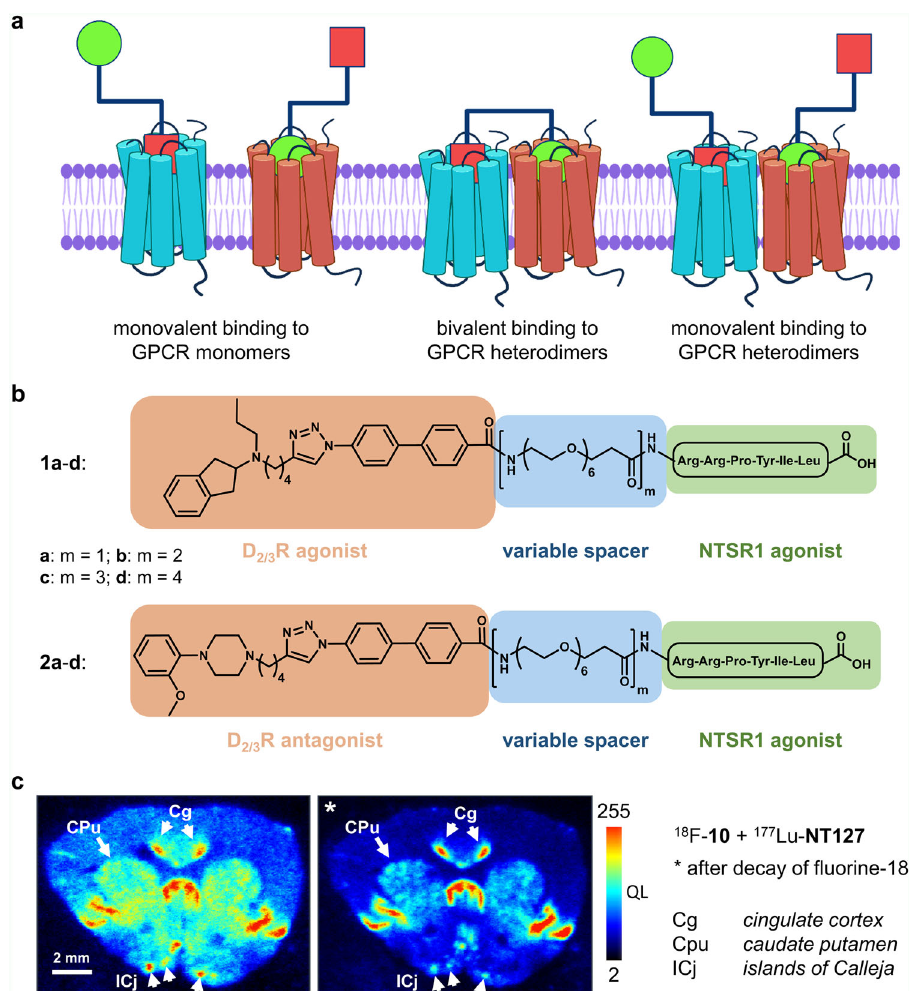
Fig. 1 Bivalent ligands targeting heterodimers and distribution of D 3 R and NTSR1 in the rat CNS. a Schematic representation of binding modes of heterobivalent ligands at dimeric or monomeric GPCRs, created with biorender.com. b Bivalent ligands used in the present study are composed of a dopamine receptor agonist ( 1a - d ) or antagonist ( 2a - d ), a linker of fl exible size ( m = 1-4 PEG-spacer units) and NT(8-13) as peptide NTSR1 agonist. c In vitro rat brain autoradiography with the D 3 R-selective radioligand 18 F- 10 39 and the NTSR1-selective radioligand 177 Lu- NT127 40 visualises the expression of D 3 R and NTSR1. The fi rst image in c is taken directly after labelling, the second autoradiography was taken 24 h later, after complete radioactive decay of 18 F, showing only expression of NTSR1. Areas labelled with the white arrows indicate coexpression of D 3 R and NTSR1. The intensity is shown as quantum level (QL) as provided by the software Quantity